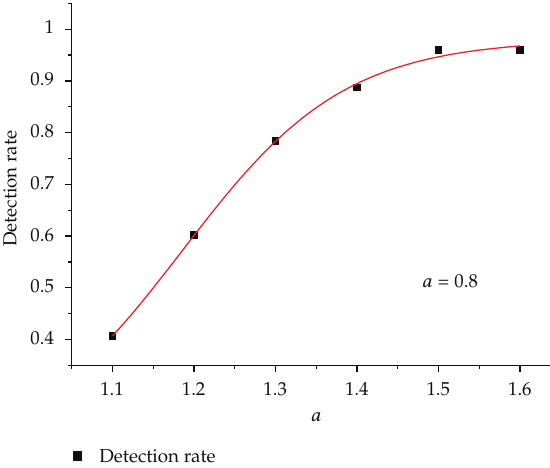
Figure 5: Detection rate with respect to b when a (cid:8) 0 .